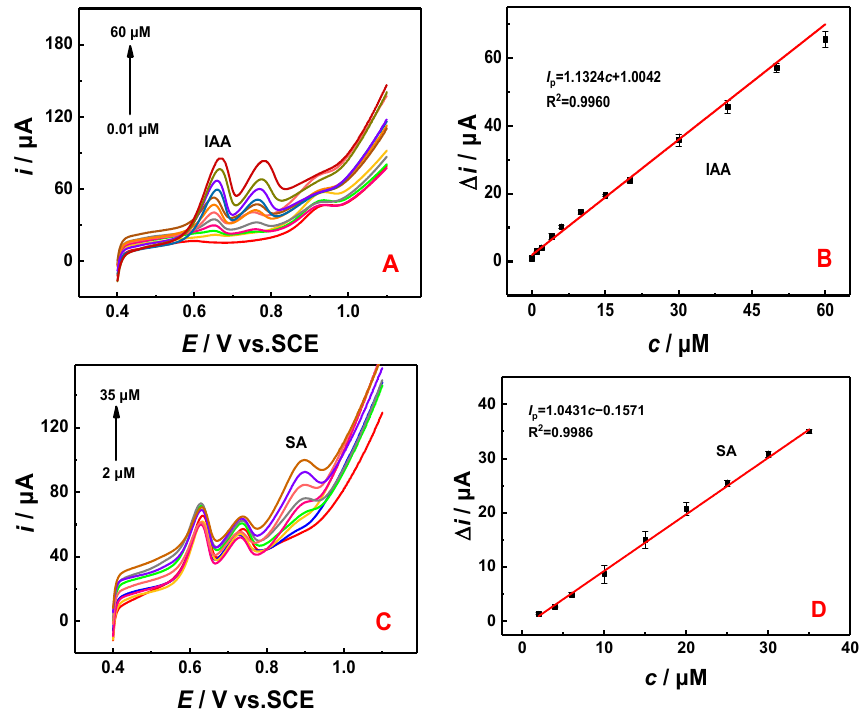
Figure 9. LSV curve of CuNPs-CSF-CNPs-MWCNTs/GCE in 0.1 M PBS (pH = 7.0) containing different concentrations of IAA (0.01, 1, 2, 4, 6, 10, 15, 20, 30, 40, 50, 60 µ M) ( A ) and SA (2, 4, 6, 10, 15, 20, 25, 30, 35 µ M) ( C ), respectively. Linear correlation curve between peak current and concentrations of IAA ( B ) and SA ( D ), respectively.